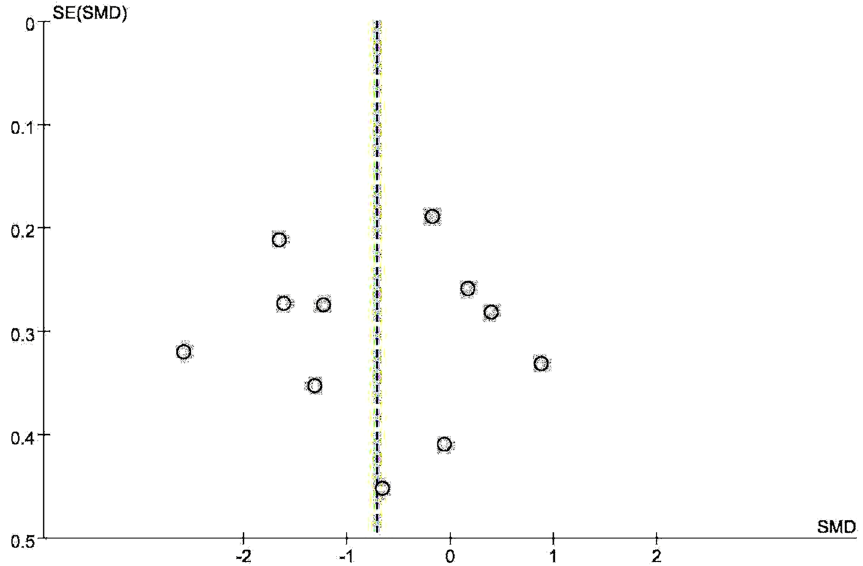
Figure 4. Funnel plot of the effect of VR on